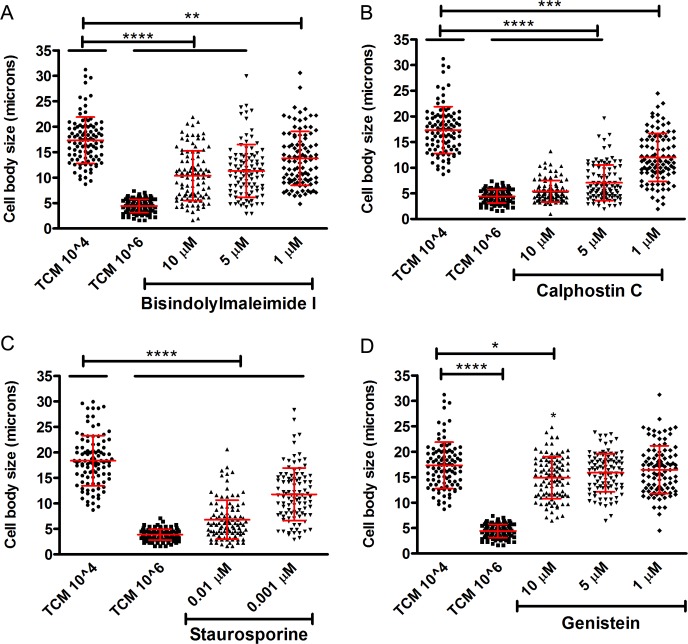
Influence of PKC pathway on titan-like cell formation.The influence of the PKC pathway was evaluated by its inhibition with three different agents: Bisindolylmaleimide I (A), Calphostin C (B), Staurosporine (C). Genestein, a tyrosine kinase inhibitor, was used as control (D). The experiments in A, B and D were performed the same days, so they share the same control. However, for clarity, the graphs corresponding to each inhibitor have been separated. The experiments were repeated on three days, and the data from the three experiments is plotted. Cells of the H99 strain were incubated with these different agents overnight in TCM at 37°C with 5% CO2 without shaking and cell body size was measured. The asterisks indicate statistical significant differences.